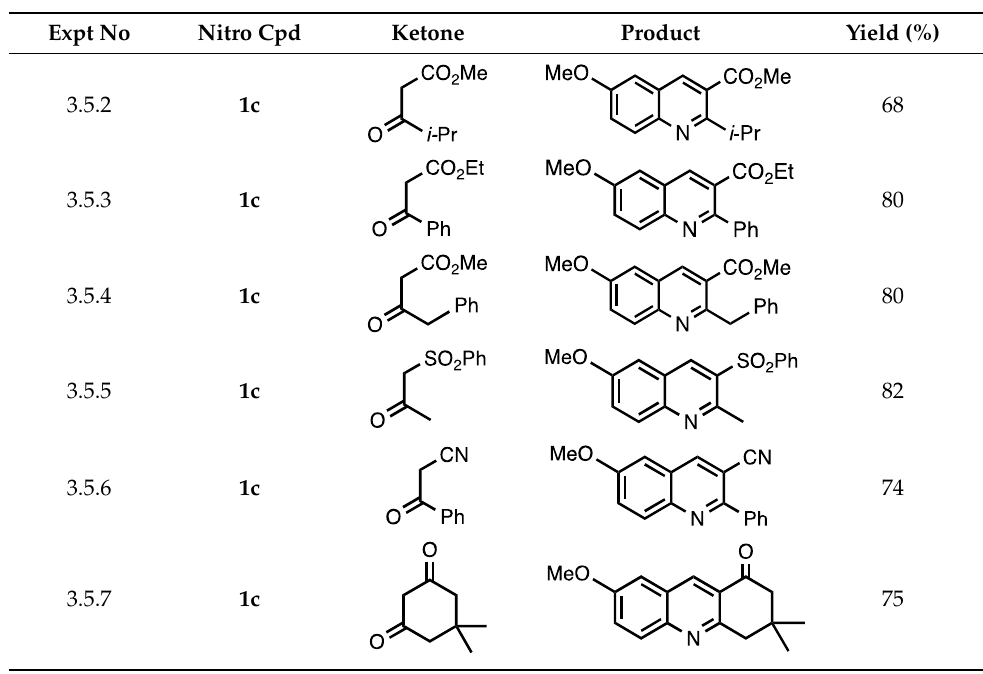
Table 3. Domino reduction-Friedländer reaction using 5-methoxy-2-nitrobenzaldehyde ( 1c ).